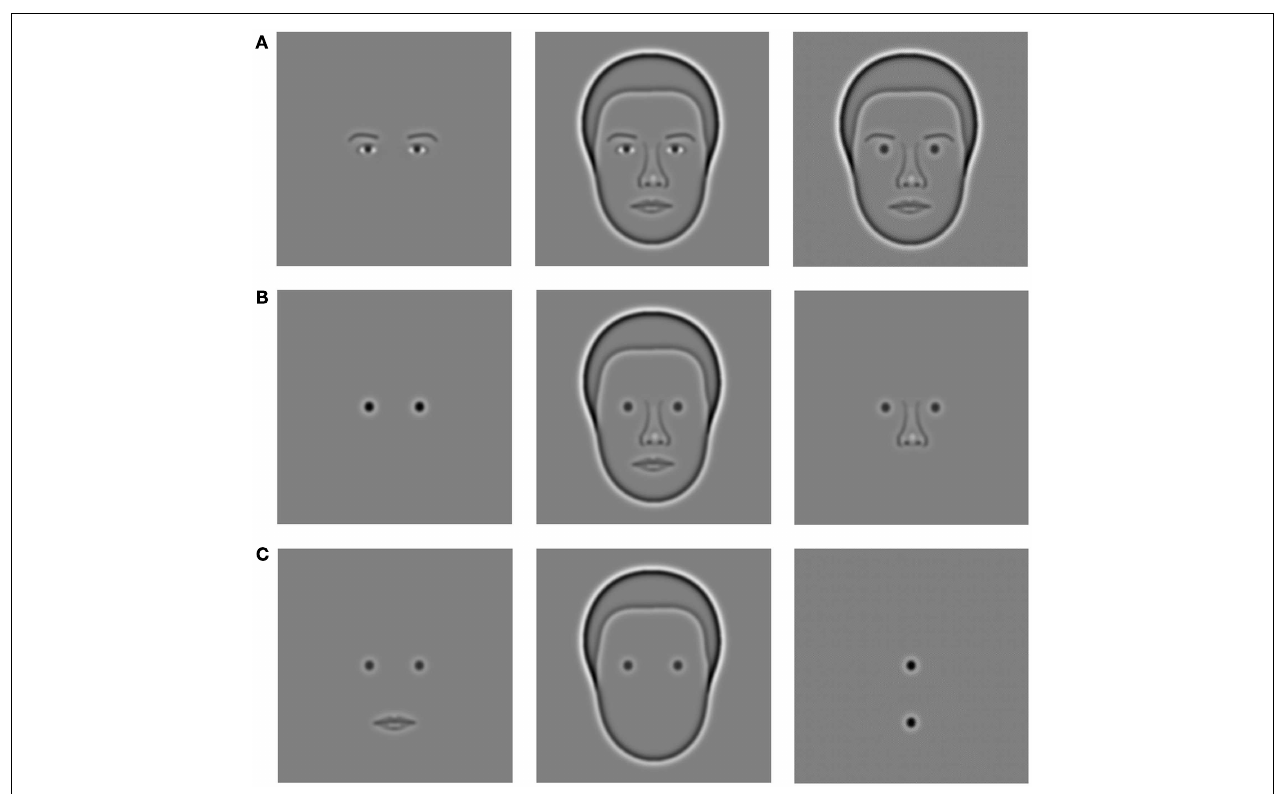
FIGURE 1 | Major stimuli used for experiments. Row (A) (left to right): eyes alone, face with eyes, face with DOGs, and eyebrows. Row (B) (left to right): DOGs alone, face with DOGs, nose and DOGs. Row (C) (left to right): mouth and DOGs, outline and DOGs, vertical DOGs.